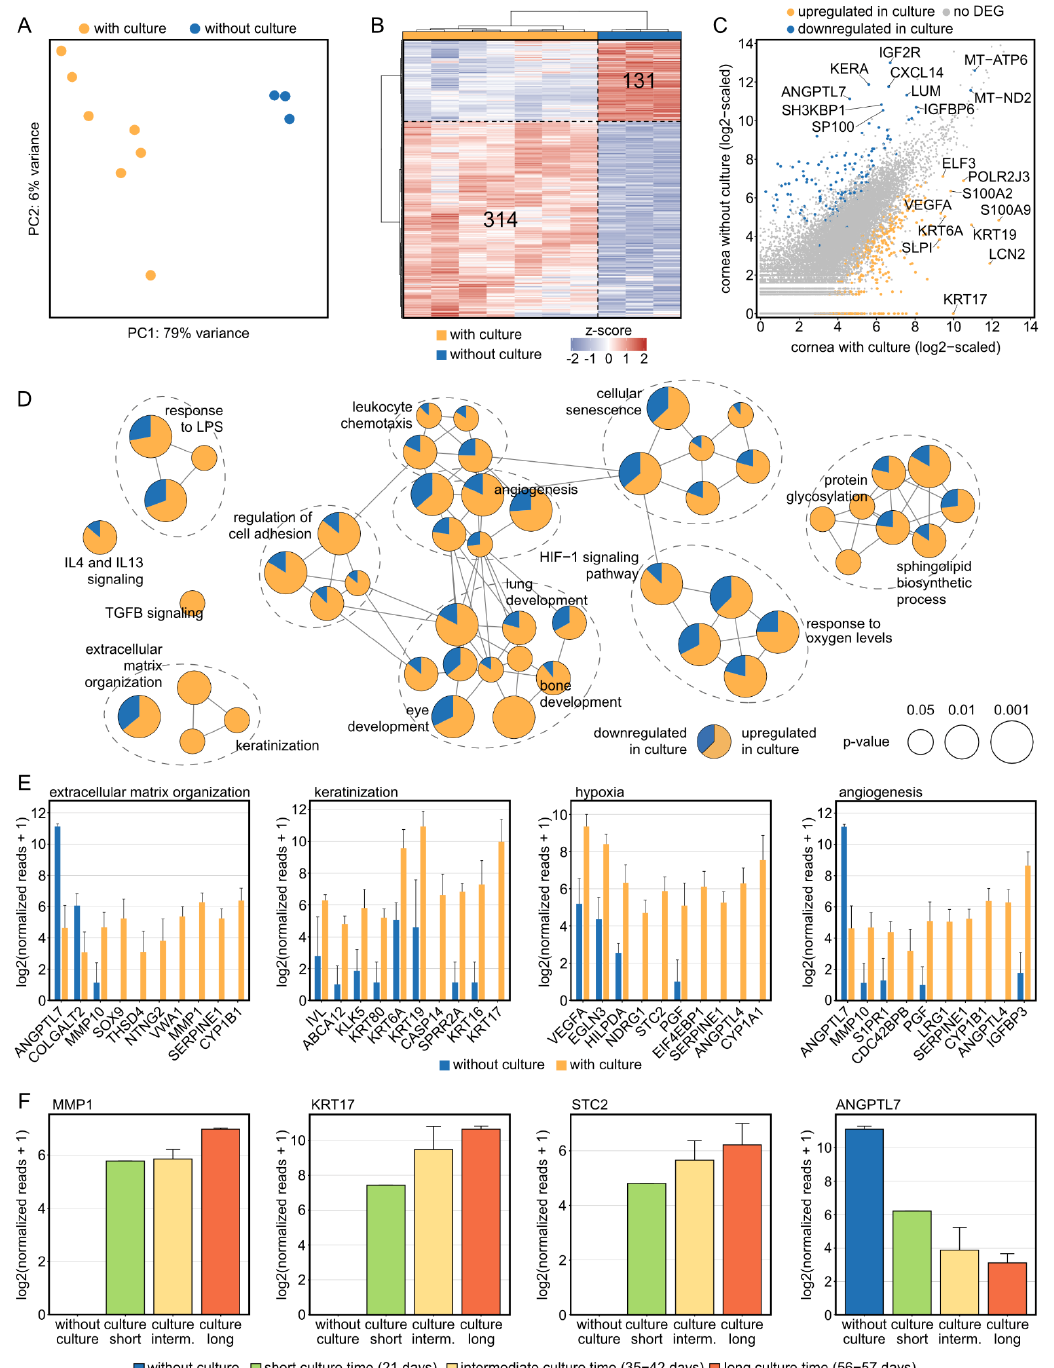
Figure 2. Corneal tissue culture significantly modulates the transcriptional profile of human corneas. ( A ) The substantial effect of organ culture is illustrated by unsupervised cluster analysis using principal component analysis. PC: principal component. ( B ): Heatmap visualizing the 314 significantly up- and 131 significantly downregulated genes by tissue culture. The z-score represents a gene’s expression in relation to its mean expression by standard deviation units (red: upregulation, blue: downregulation). ( C ): Readplot visualizing differentially expressed genes (DEG) between corneas with and without cul- ture. The top 10 DEG per group are labeled. ( D ): Functionally grouped network analysis of enriched Gene Ontology biological processes, reactome, KEGG, and Wiki pathways in which the DEG were involved in. Enriched terms are visualized as nodes being linked based on their kappa score,